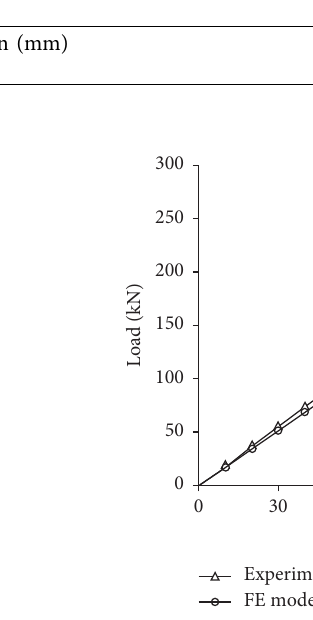
Figure 7: Failure test: mid-span deflections up until failure. Experimental tests and numerical